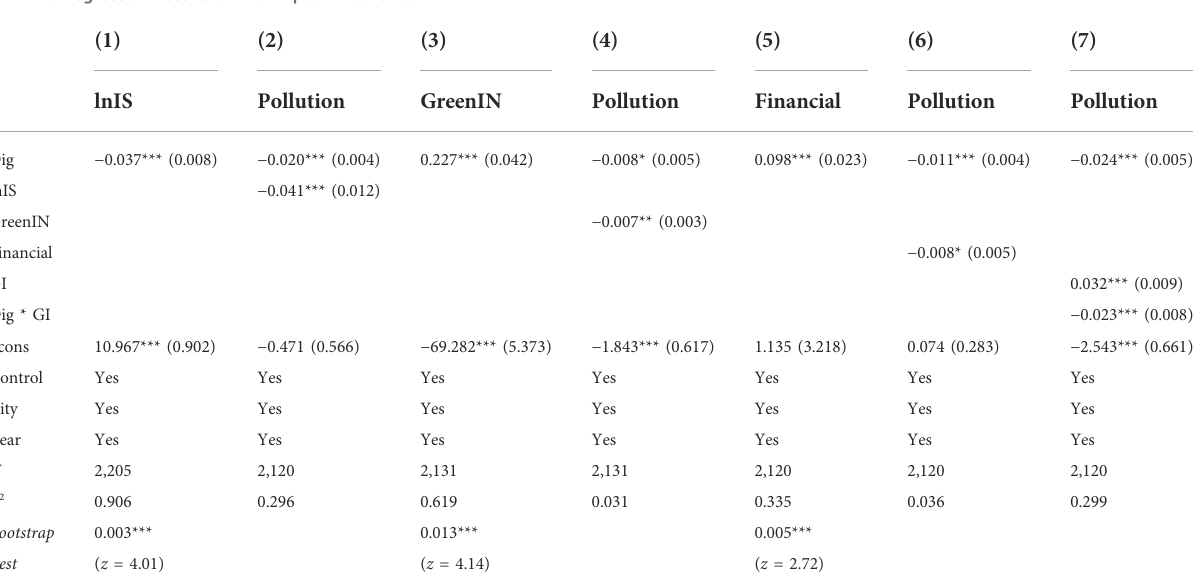
TABLE 5 Regression results of the impact